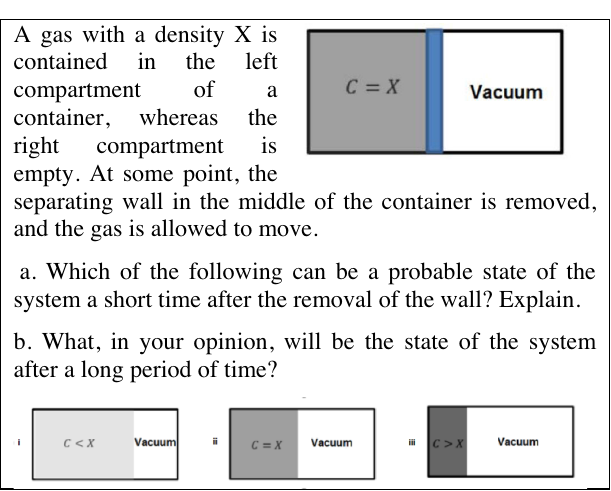
FIG. 2. An interview question on gas expansion that promotes several productive reasoning resources related to entropy, random motion, and